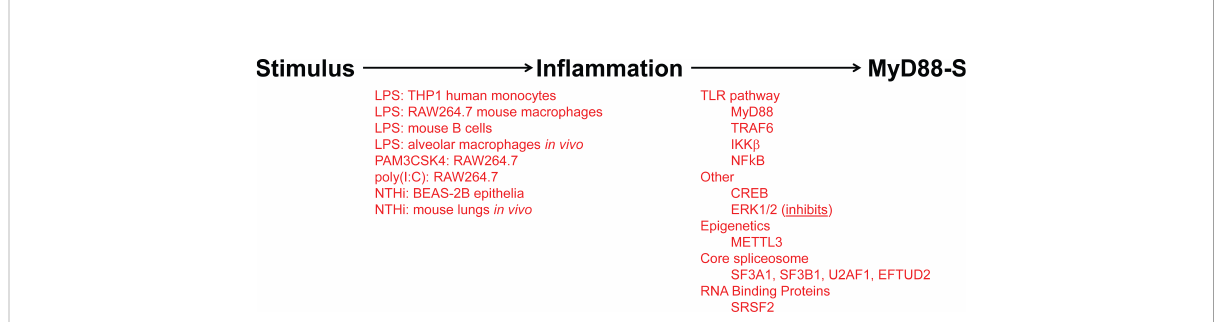
FIGURE 5 In fl ammatory stimuli and signaling proteins that regulate MyD88-S production. On the left (in red) are listed all the in fl ammatory stimuli that have been reported to induce MyD88-S expression. On the right (in red) are listed all the proteins that have been reported to mediate the stimuli-induced increase in MyD88-S